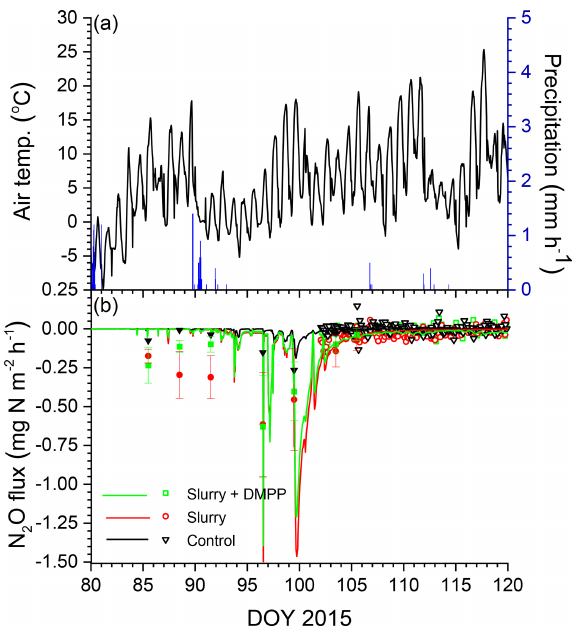
Figure 5. (a) Air temperature and precipitation and (b) N 2 O fluxes measured (symbols) and modelled (lines) during early spring 2016 with no slurry (control) and following slurry application on DOY 280 in 2015 with or without DMPP. Filled symbols represent manual chamber measurements. Negative values denote